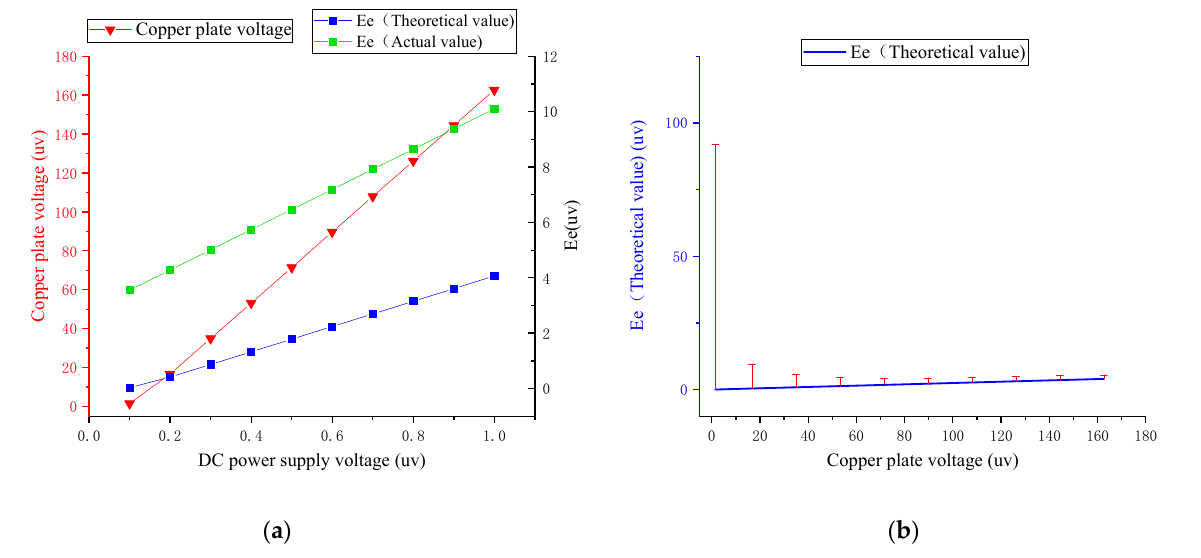
Figure 7. Analysis of DC electric field test results: ( a ) trend between copper voltage input and XCP-induced different voltage Ee; ( b ) error analysis of different XCP induction voltage Ee under copper plate voltage.